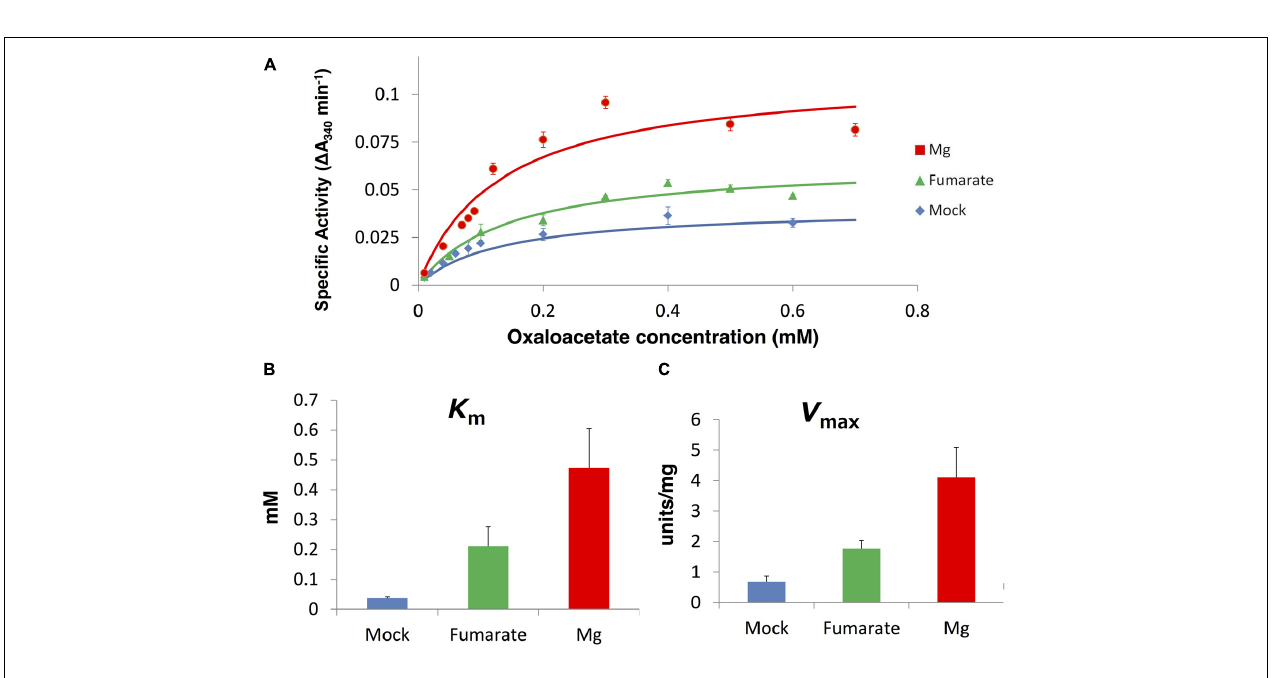
FIGURE 5 | The K m and V max -values for oxaloacetate in the presence of 10 mM fumarate and 10 mM magnesium ion in vitro . (A) Saturation curves of the activity of Sy MDH. Blue line indicates mock, green line indicates presence of fumarate, and red line indicates the presence of magnesium. The graph shows the mean of three independent experiments. (B) K m (mean ± SD) (units/mg protein) values in the presence of 10 mM fumarate and 10 mM magnesium ion, obtained from three independent experiments. (C) V max (mean ± SD) values for oxaloacetate, obtained from three independent experiments. Mock indicates the enzymatic activity in the absence of additional